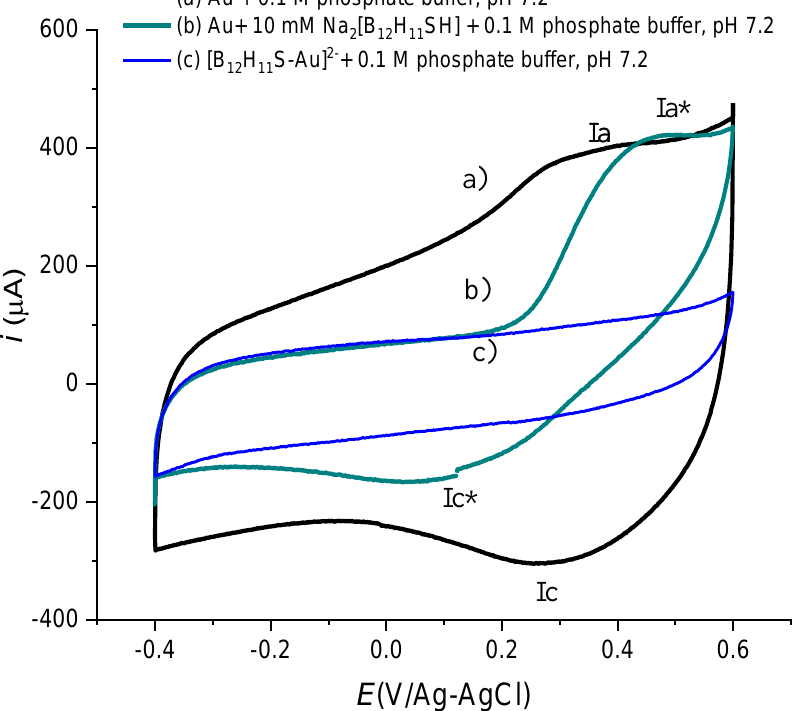
Figure 1. Cyclic voltammetry obtained with a Bare Au electrode (a) 10 mM of Na 2 [B 12 H 11 SH] in the presence of 0.1 M phosphate buffer, pH 7.2, scan rate 50 mVs − 1 obtained with (b) bare Au electrode and (c) after modification with [B 12 H 11 SH] 2 − .